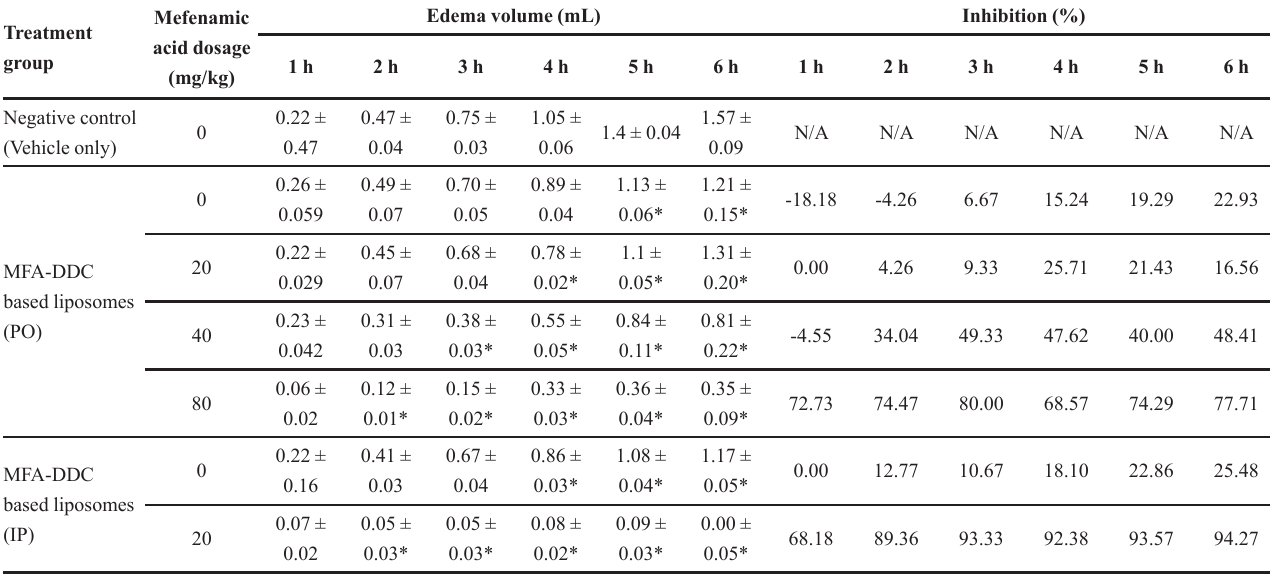
TABLE VI - Mean edema volume and percentage of inhibition at different time intervals in carrageenan-induced paw edema test